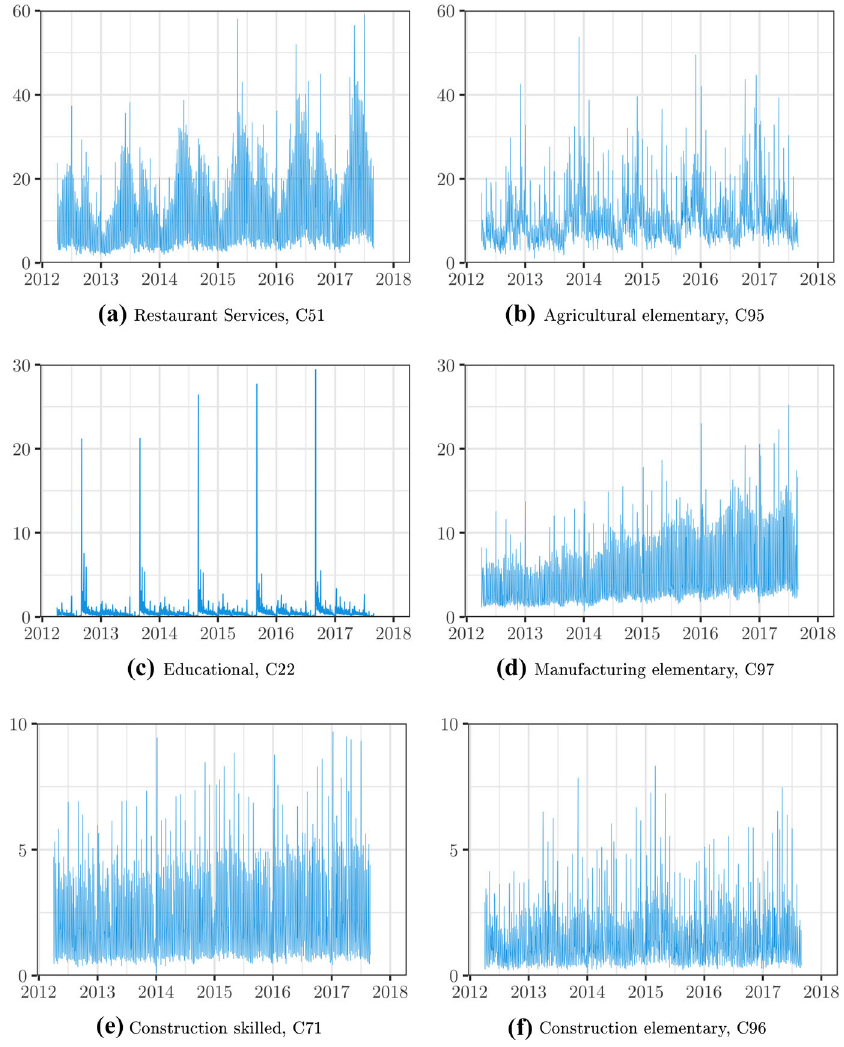
Fig.10 Daily contracts in selected sectors according to SEPE (note scale from top to bottom in thousands: 60,000, 30,000,